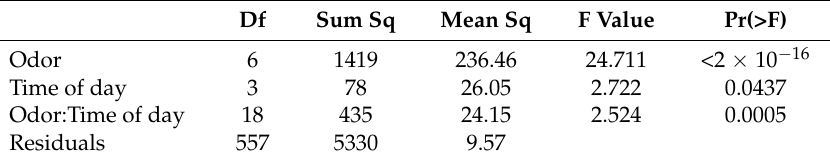
Table 1. Analysis of variance (ANOVA) reveals that odorant sensitivity of female Ae. aegypti mosquitoes is significantly modulated by the odorant stimulus, the time of day, and the interaction between these two factors. Df : Degrees of Freedom; Sum Sq: sums of squares; Mean Sq: mean of squares; F value: values of the F statistic; Pr(<F): the probability of observing an F ratio greater than the corresponding F